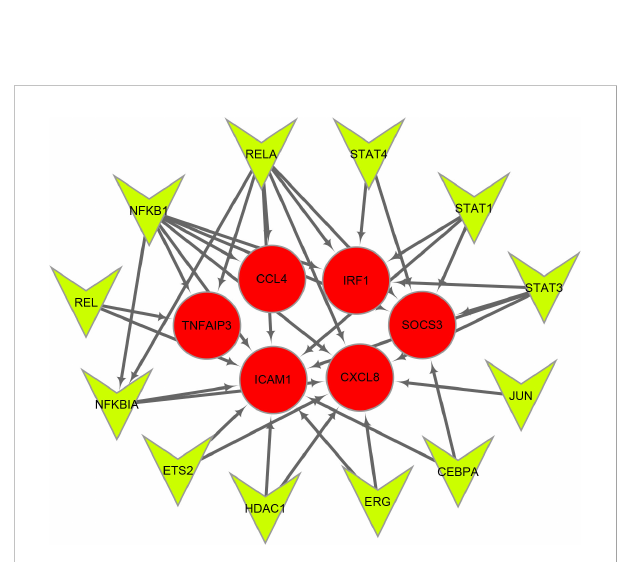
FIGURE 6 Transcription factors (TFs) regulatory network of immune-related hub genes. TFs are represented as green triangles and immune- related hub genes are represented as red circles.